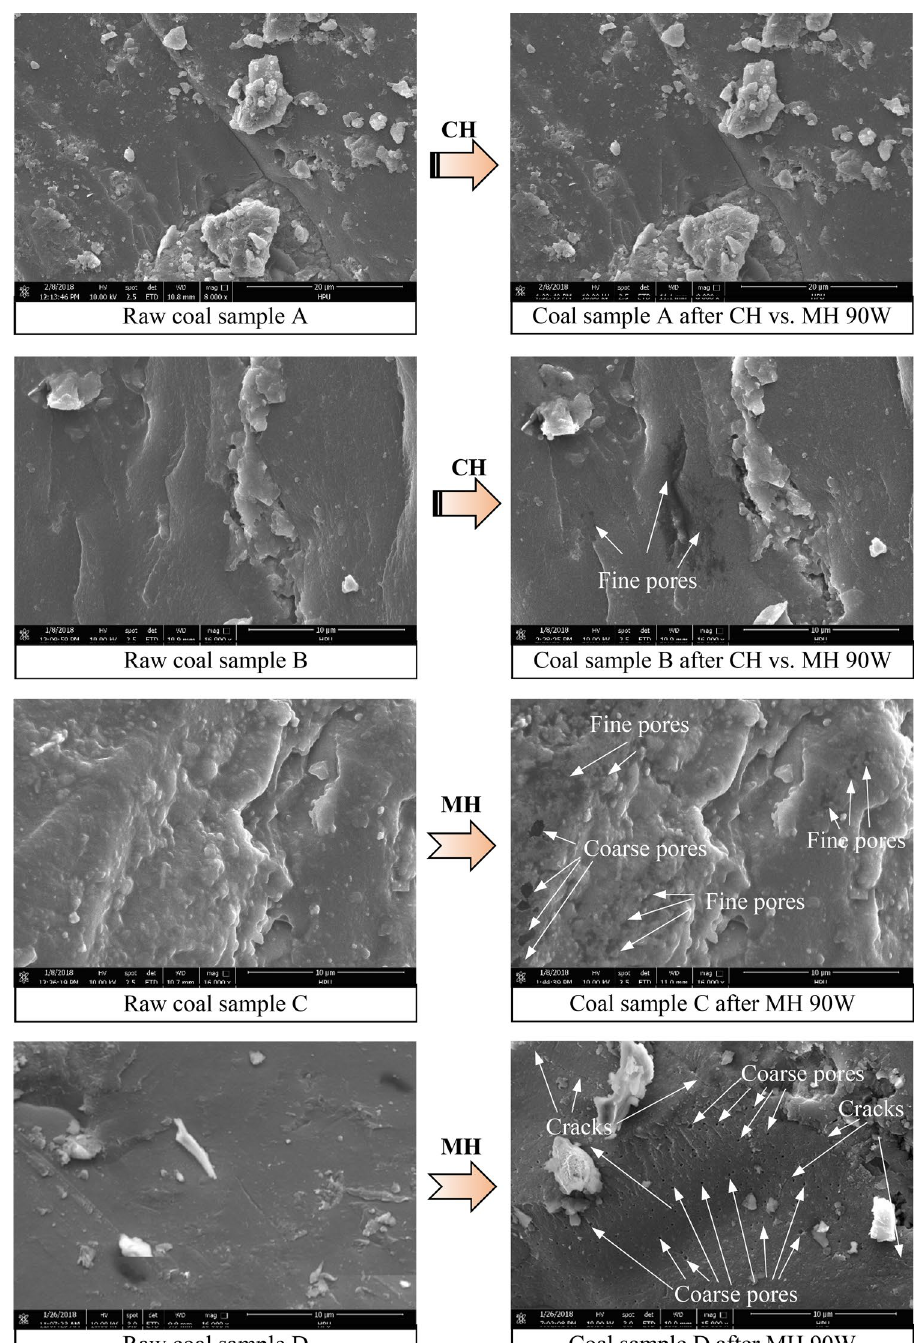
Figure 13. Representative SEM images showing changes on the surfaces of coal samples before and after MH and